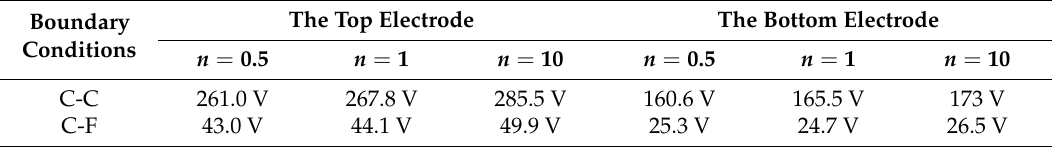
Table 5. Static pull-in voltage for C-C and C-F boundary conditions and various volume fractions.